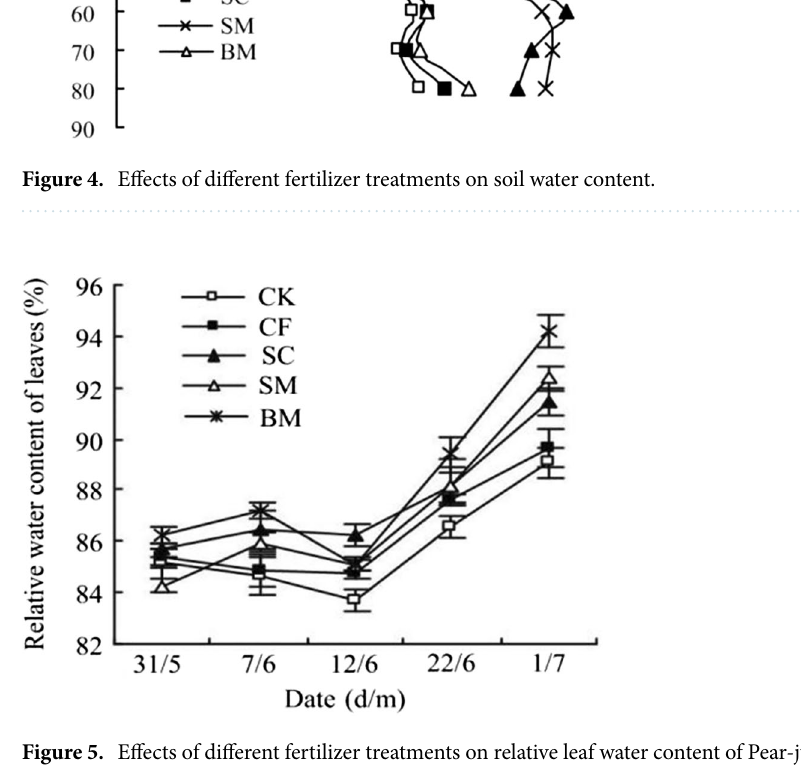
Figure 5. Effects of different fertilizer treatments on relative leaf water content of Pear-jujube.